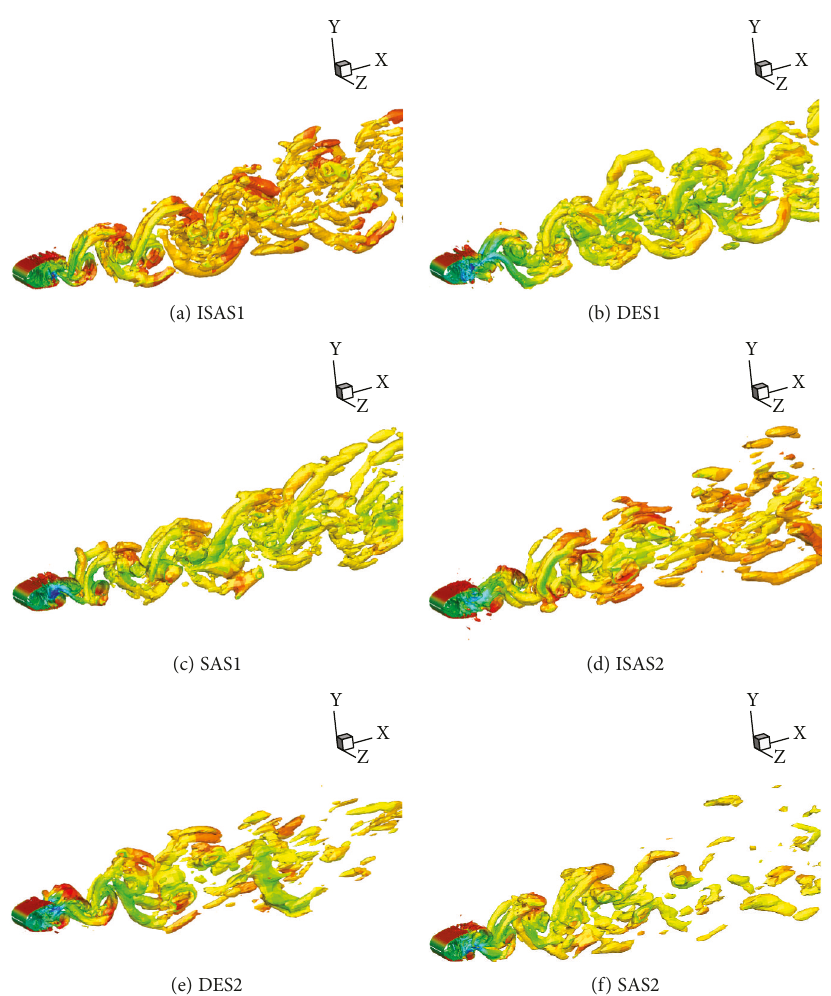
Figure 13: Instantaneous turbulent structures identi fi ed by the Q -criterion.